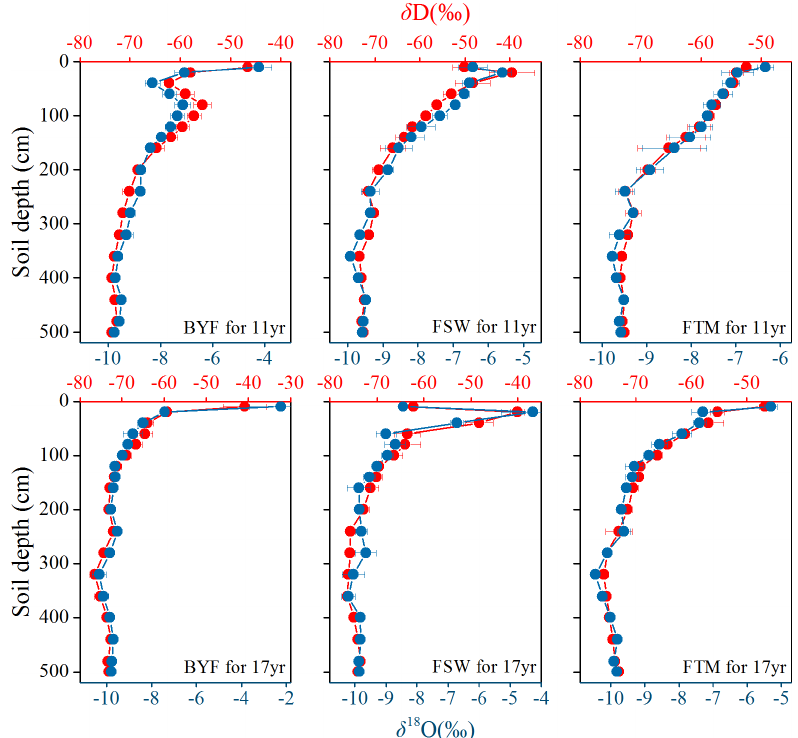
Figure 6. δ D and δ 18 O values in soil water down the soil profile during the apple growing season in 2019. Values are means ± SD ( N =